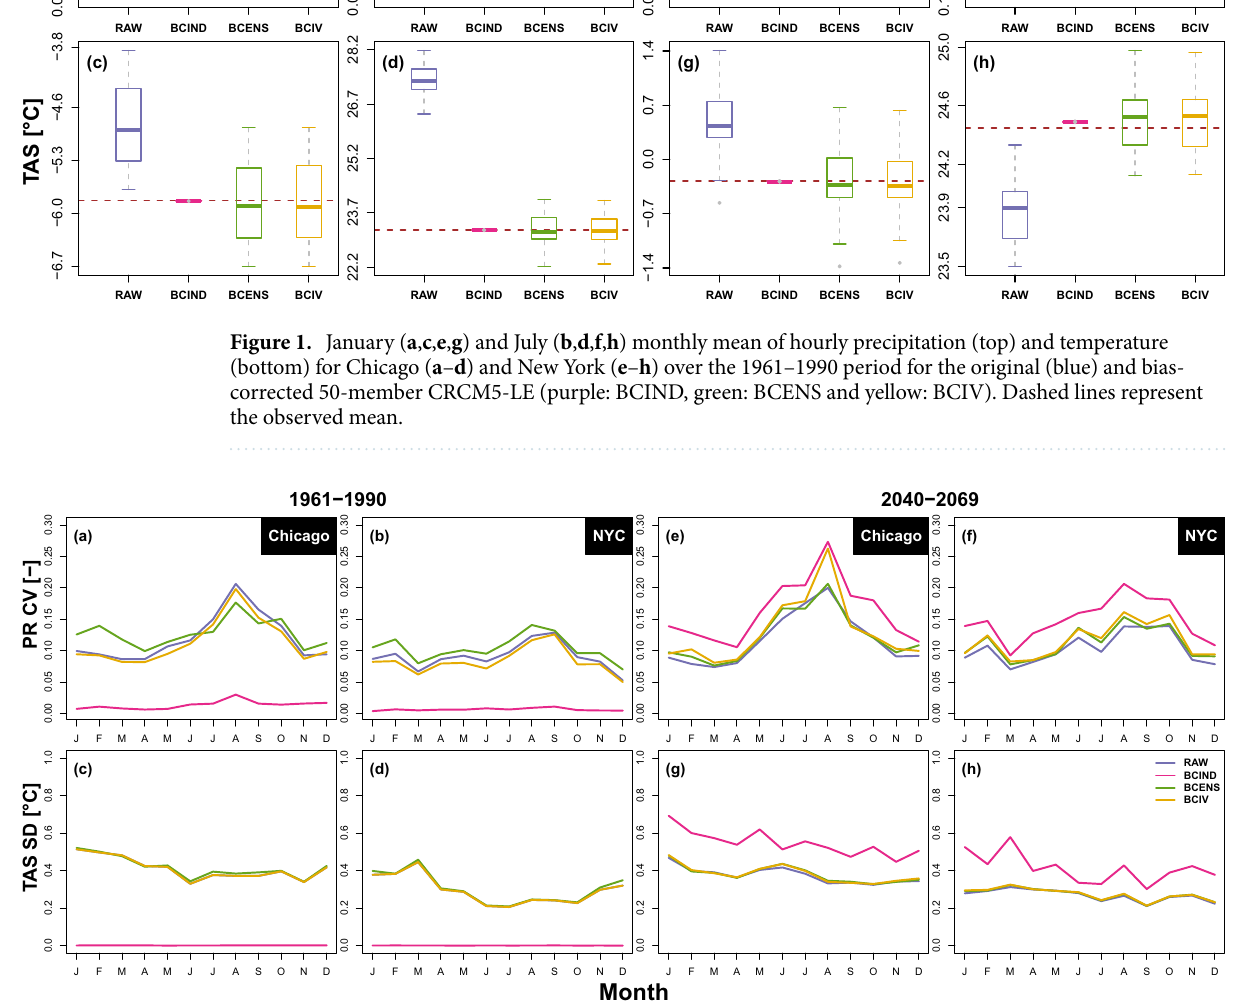
Figure 2. Monthly CVs of hourly mean precipitation (top) and temperature SD (bottom) for Chicago ( a , c , e , g ) and New York ( b , d , f , h ) over the 1961–1990 ( a – d ) and 2040–2069 ( e – h ) periods. The blue, purple, green and yellow lines respectively represent the CV (for precipitation) and SD (for temperature) of the original (RAW) and the BCIND, BCENS and BCIV corrected